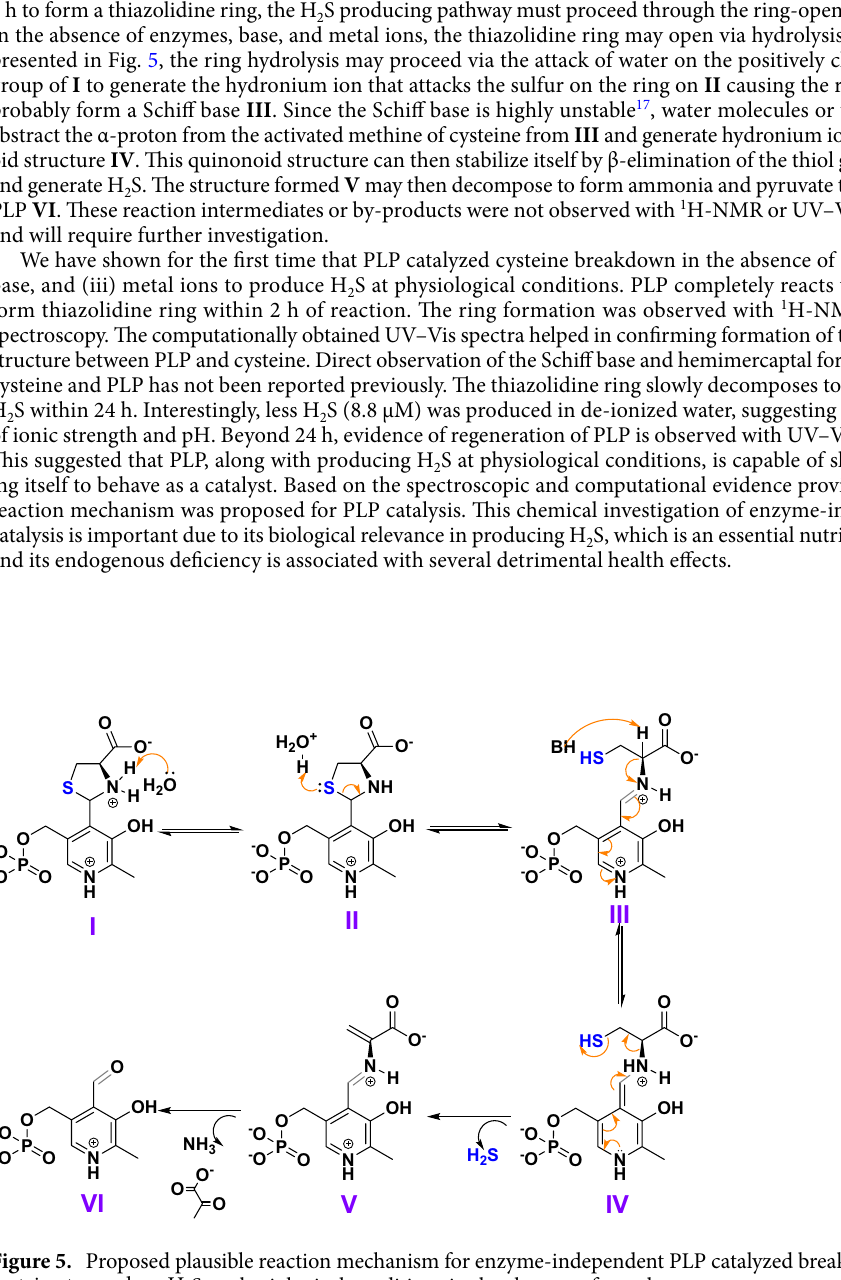
Figure 5. Proposed plausible reaction mechanism for enzyme-independent PLP catalyzed breakdown of cysteine to produce H 2 S at physiological conditions in the absence of